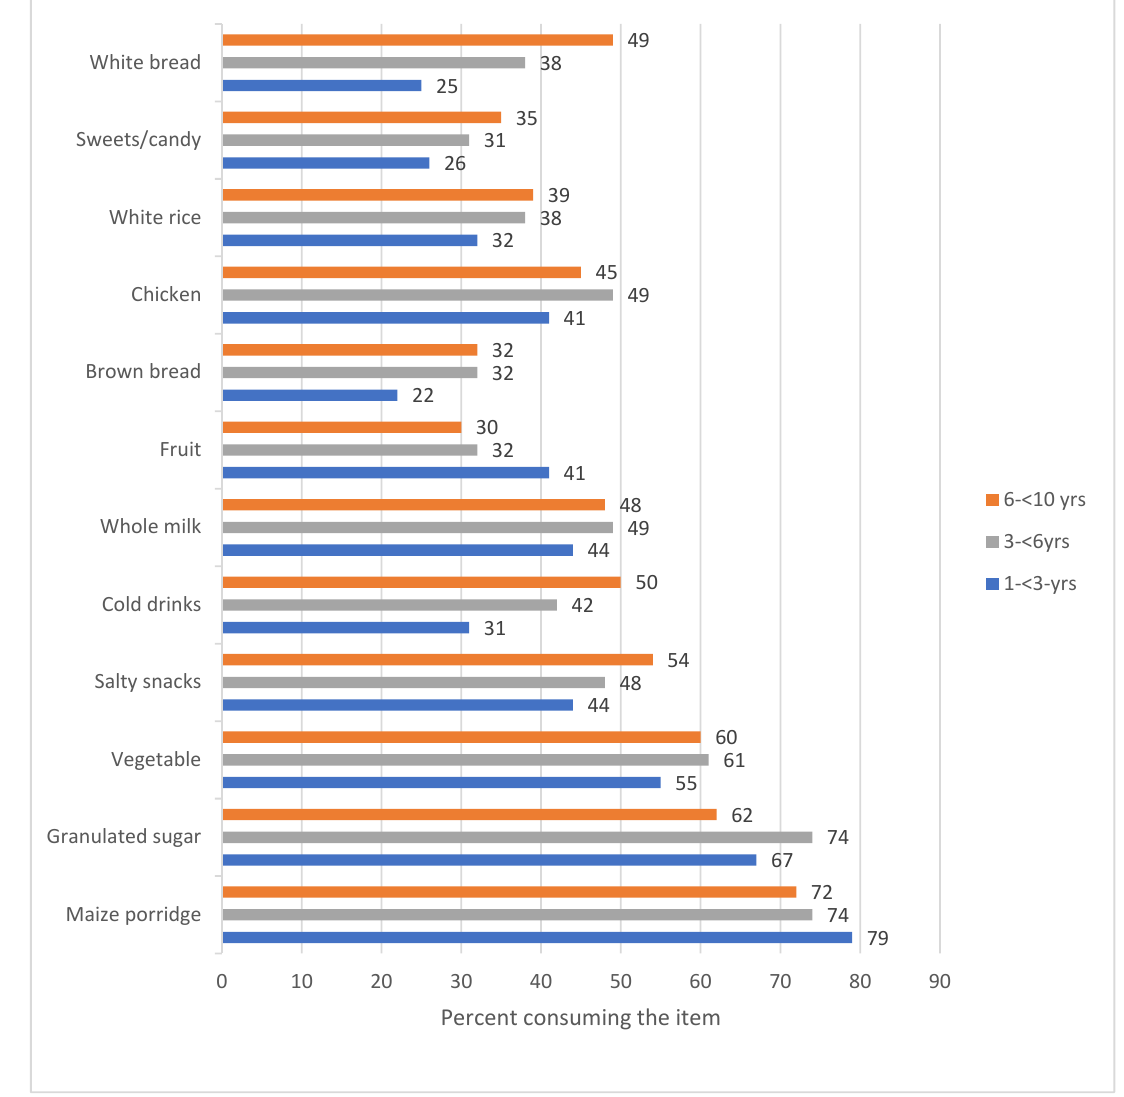
Figure 3. The twelve most commonly consumed food items by all children by age group.